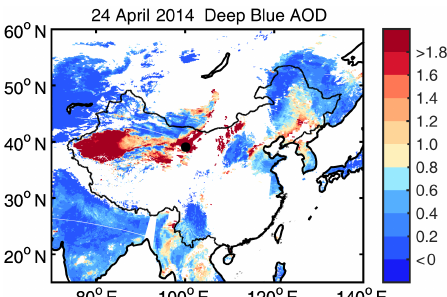
Figure 10. Terra MODIS Deep Blue AOD measured at 550nm by the NASA Giovanni system during a heavy dust storm on 24 April 2014. The black dot represents the location of the ground-based mo- bile laboratory at Zhangye.